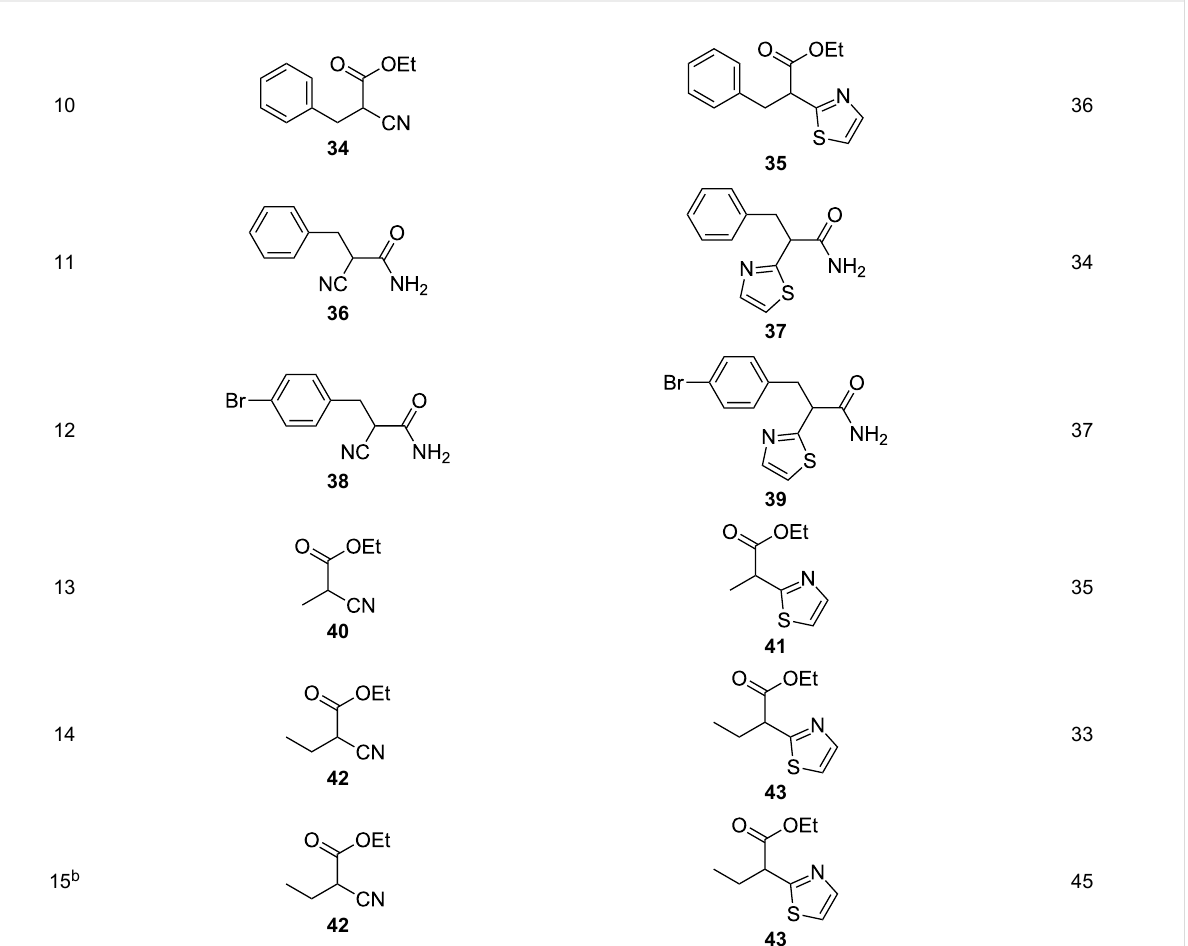
Table 4: Scoping of the 2-substituted thiazole formation. a